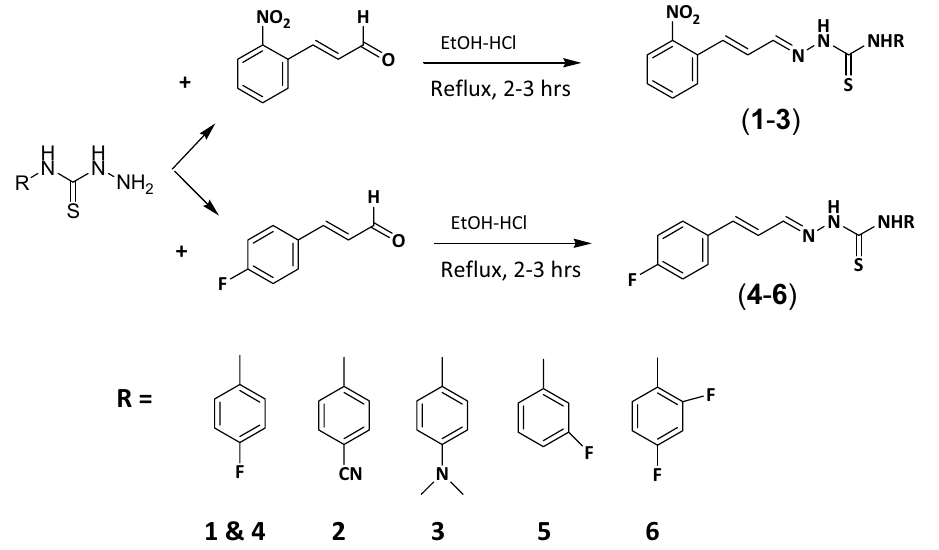
Scheme 1. Synthesis of receptor compounds 1–6 .